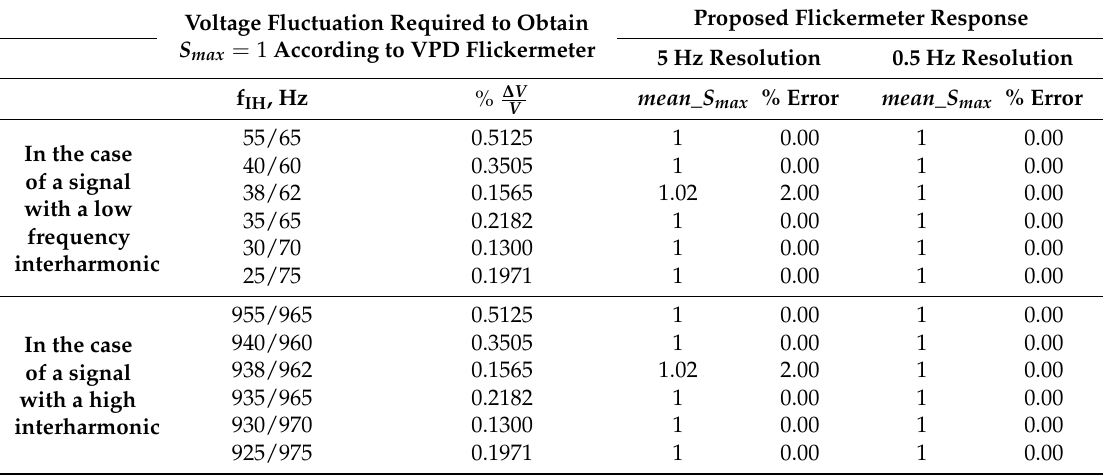
Table 4. Proposed VPD Flickermeter response for various sinusoidal voltage fluctuations.